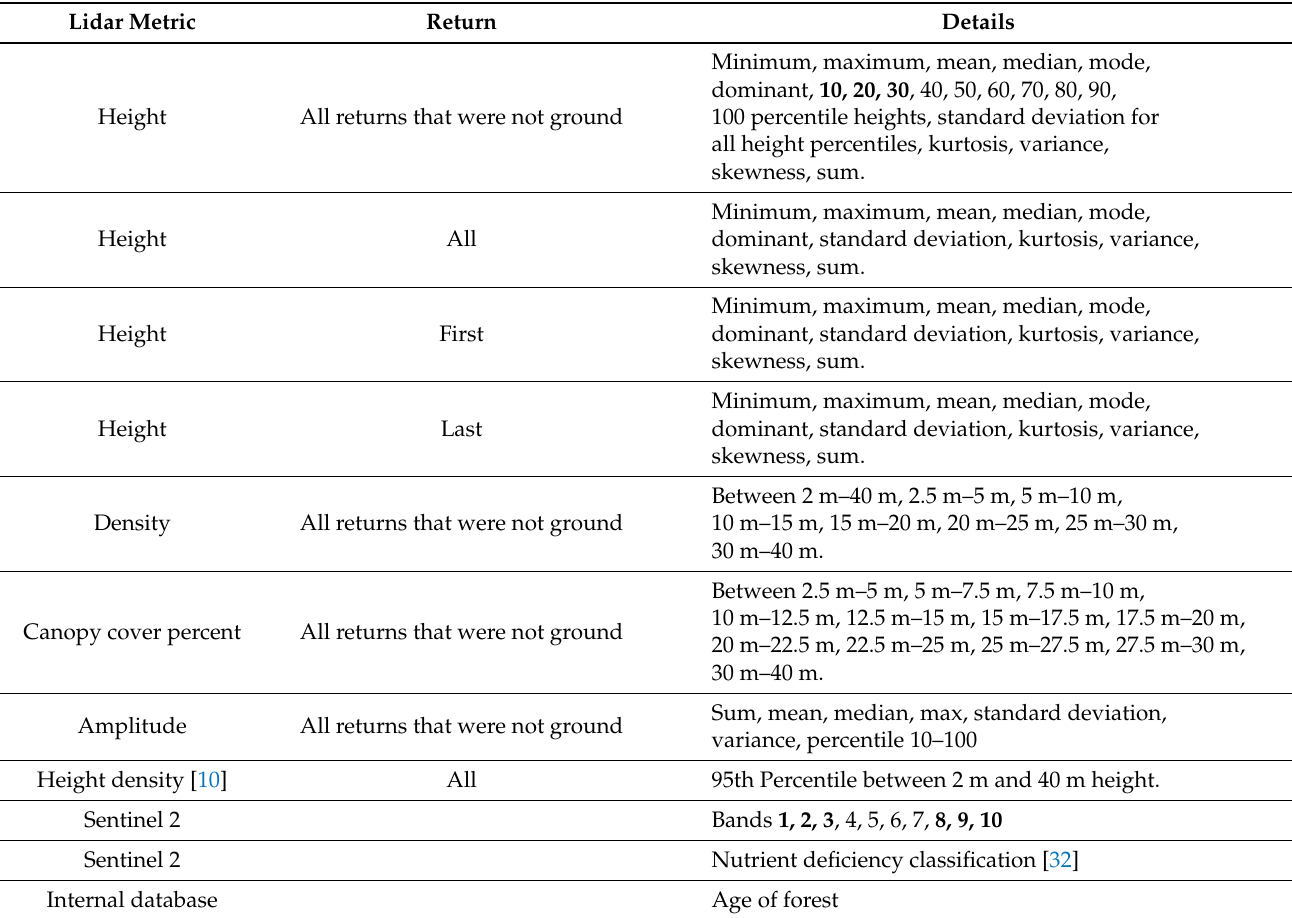
Table 5. Auxiliary variables used during